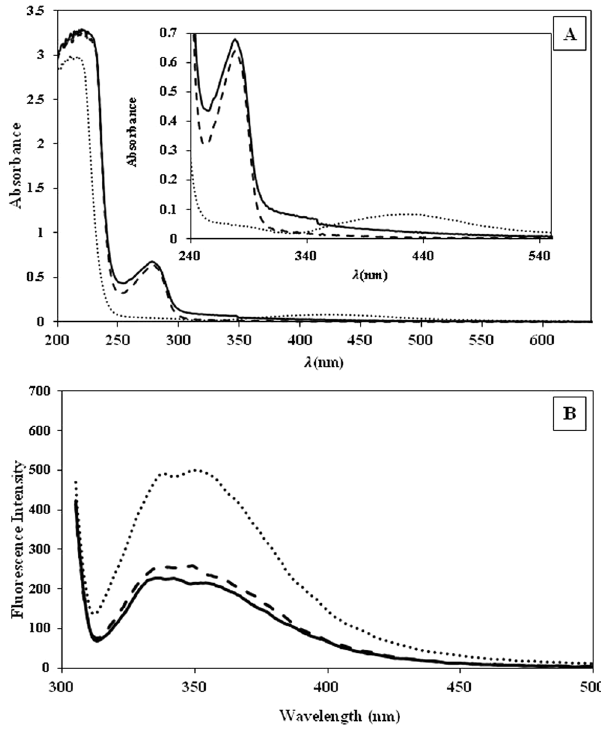
Figure 4. ( A ) UV-Vis spectra of ASNPs (solid line), SNPs (dotted line) and BSA (dashed line). The inset plot shows a magnification of the absorption peak. ( B ) Emission fluorescence spectra of ASNPs (solid line), ANPs (dash-dotted line) and BSA (dashed line).